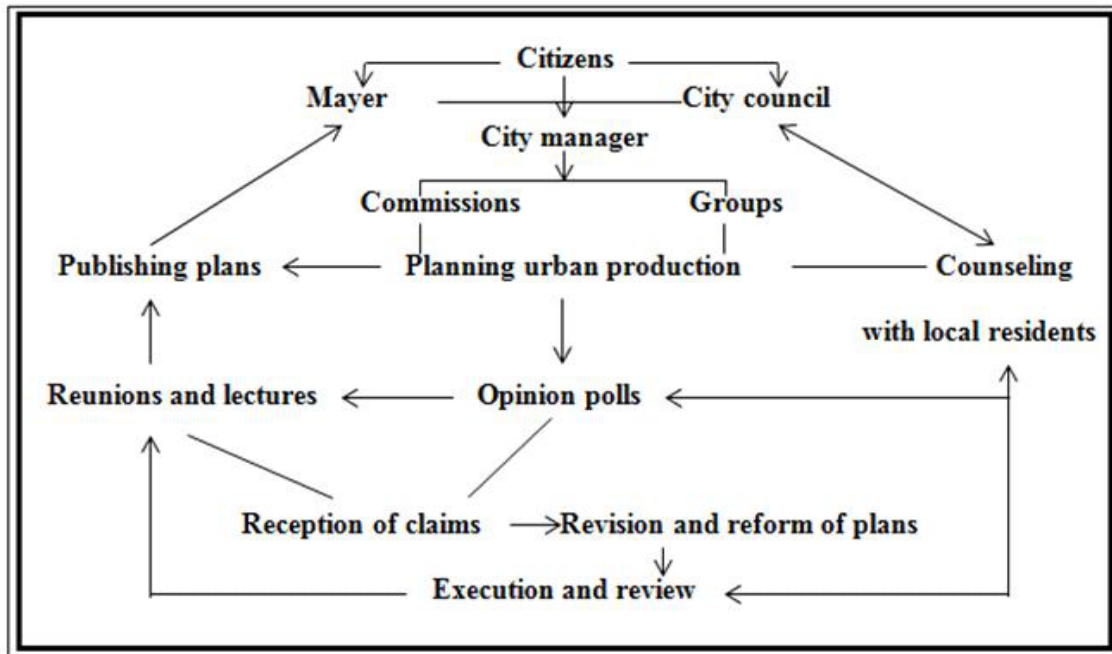
Fig. 1: Model of urban participative planning; common factors and elements that can be observed in each model form our list of developed societies (Nejati Hosseini and Kowsari,